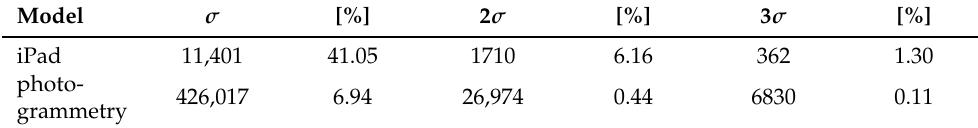
Table 6. Analysis of the number of outlying points ( σ = Q 3 =5 [cm]) for the indoor space